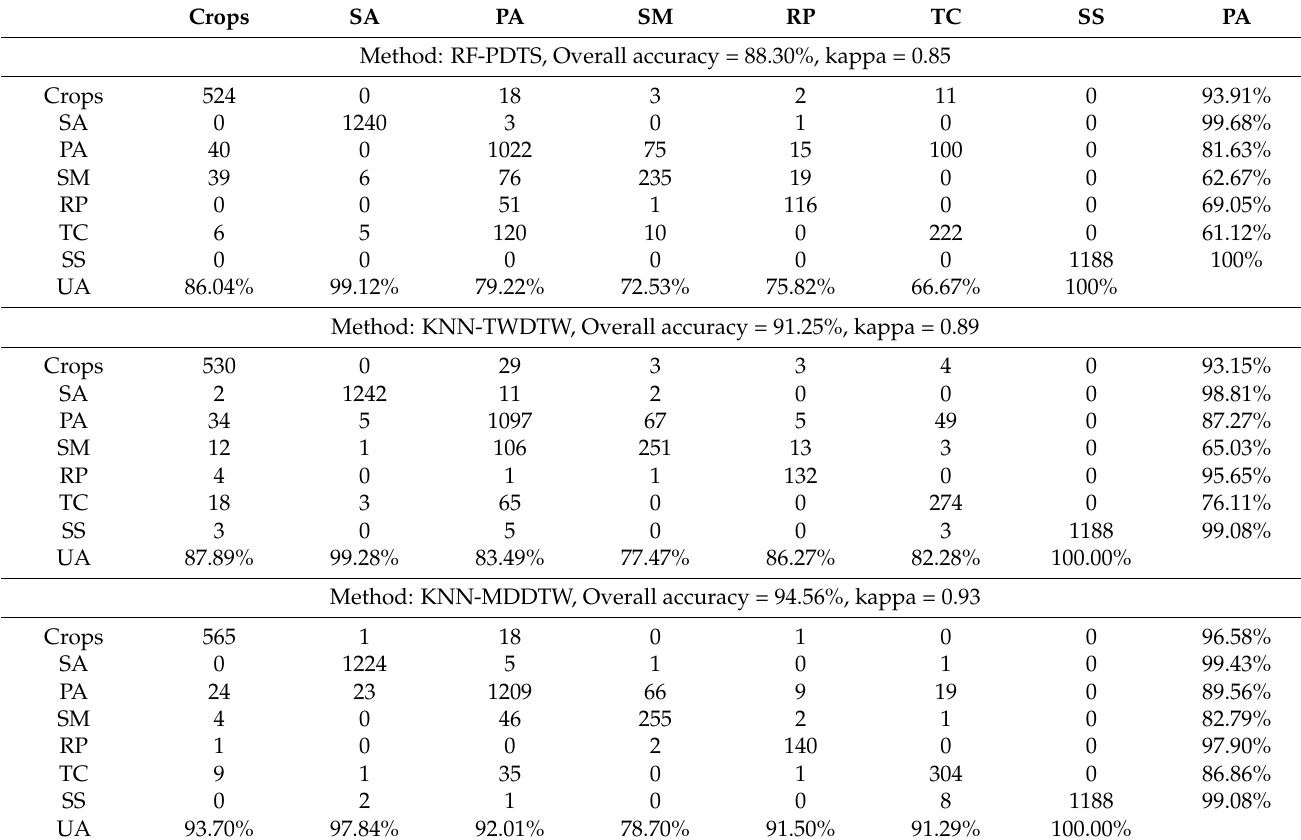
Table 3. Confusion matrix of the wetland vegetation